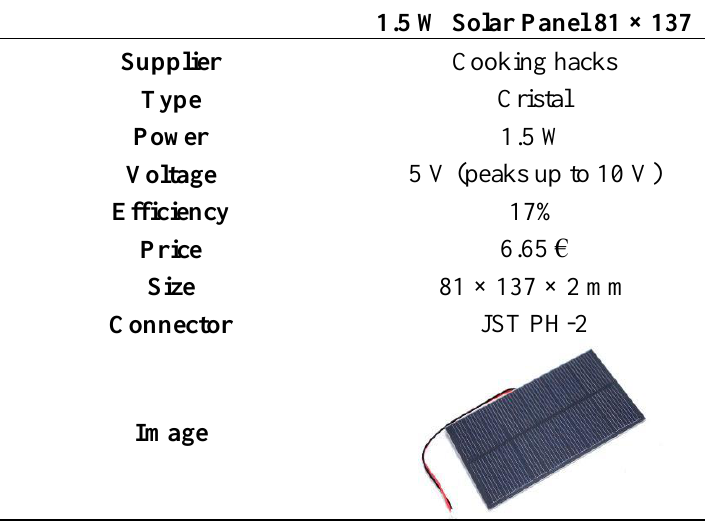
Table 6. Technical characteristics of the solar panel